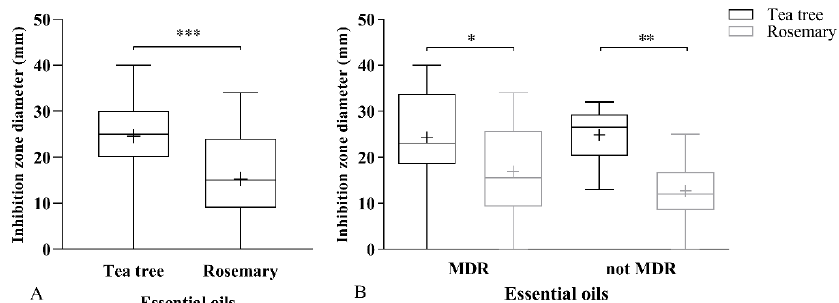
Figure 1. Aromatogram of tea tree and rosemary essential oils. Data are expressed using box and whisker plot, min to max values are presented by vertical lines, while median and mean are within the plot as horizontal line and “+” , respectively. An unpaired t -test was used to determine ( A ) statistical significances among the 23 Staphylococcus pseudintermedius (SP) strains; ( B ) stratification of the results over multidrug-resistant (MDR) ( N = 14) and non-MDR ( N = 9) strains. (* p-value between 0.05 and 0.01; ** p - value < 0.01, *** p - value < 0.001).